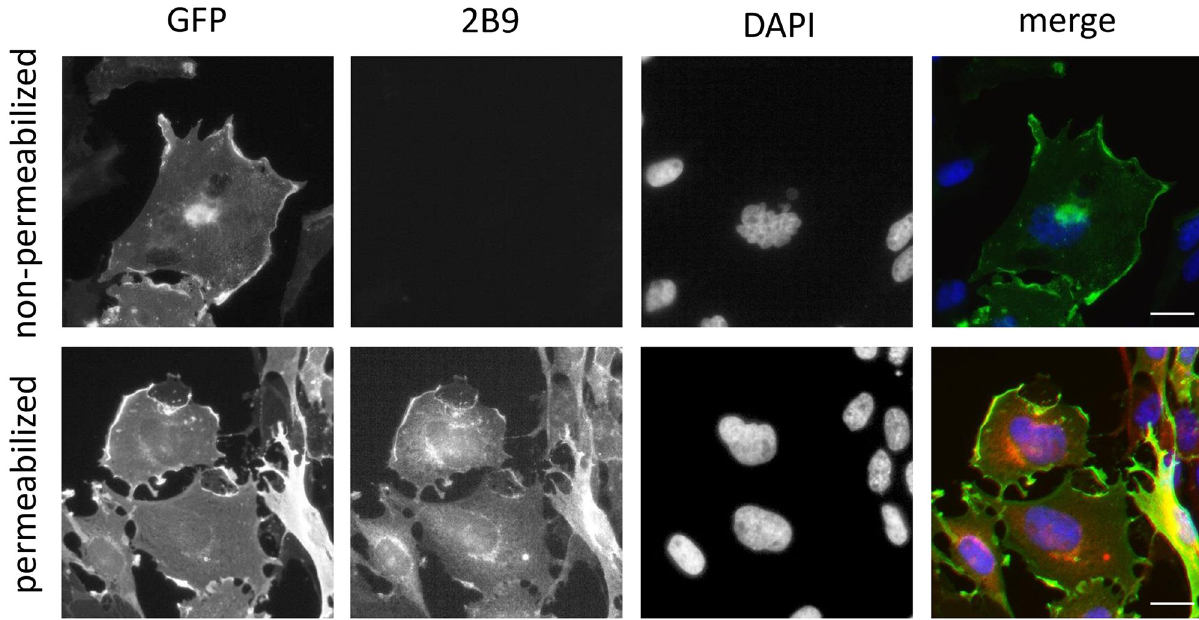
Fig 5. 2B9 binds to the intracellular domain of S1P 1 . CHO S1P 1 -GFP cells were seeded on coverslips and fixed 24h later. Permeabilized and non- permeabilized cells were stained for S1P 1 with 2B9 (red) and for DNA with DAPI (blue). Colocalization (yellow) is shown between GFP (green) and 2B9 (1:100, w/v, red) in permeabilized cells. Non-permeabilized cells are not stained with 2B9 (1:100, w/v, red). Images are representative of the population examined. Scale bar, 10 μ m.